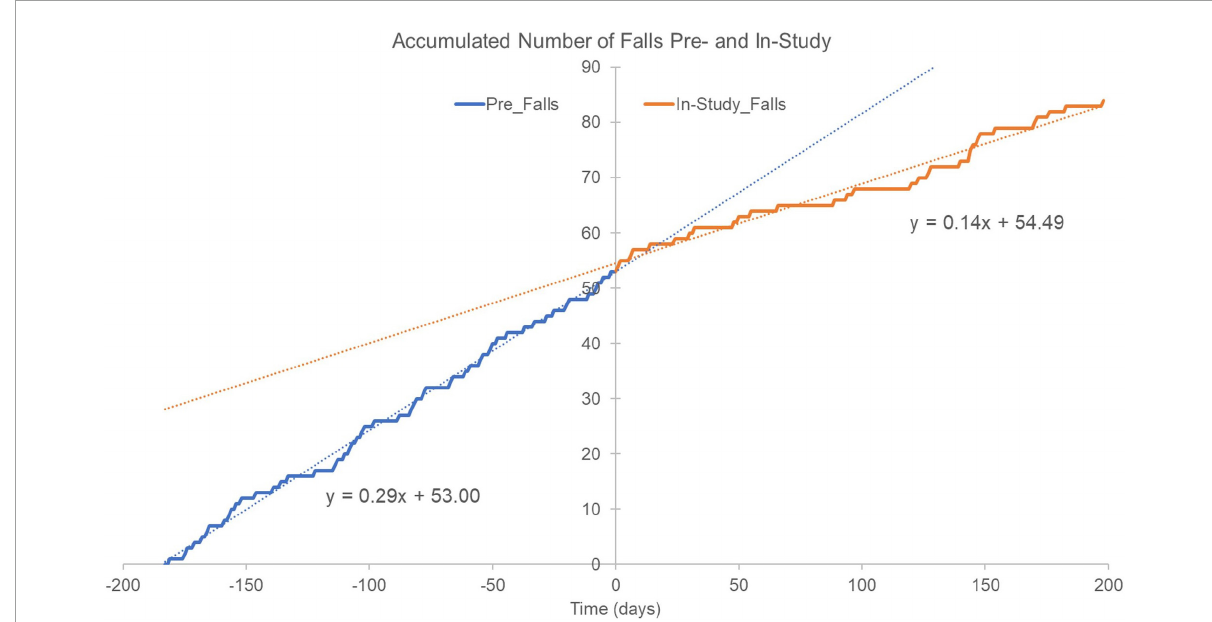
FIGURE6 Accumulated number of falls reported 6 months pre-study (blue trace and blue dotted linear regression line) and falls documented in-study (orange trace and orange dotted regression line). The 53 falls reported for the prior 6 months would correspond to 0.29 falls/day (53/180 ∼ 0.29), which represents the slope of the regression line (blue trace). For illustration purposes, the 53 pre-study falls were randomly distributed across the 6 months since their exact time occurrence was unknown. In-study falls are shown as they occurred and were reported by participants throughout the 26 weeks. Notice how the rate of in-study falls appear to begin deviating from pre-study fall rate (slope of dotted blue line) after approximately 20 days of device